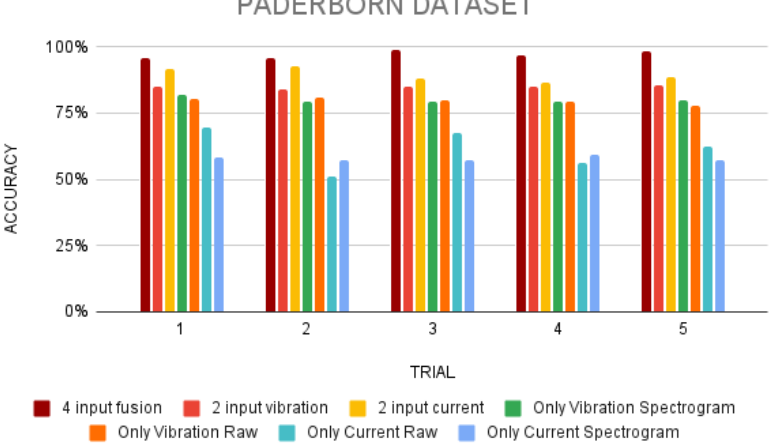
Figure 11. Paderborn dataset comparison with different methods.